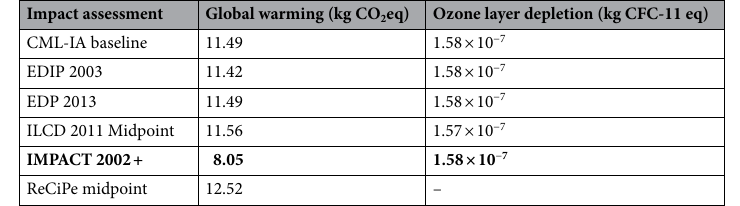
Table 5. Characterization indices of PBS edible insects determined using various IA methodologies. The base scenario is shown in bold numbers.